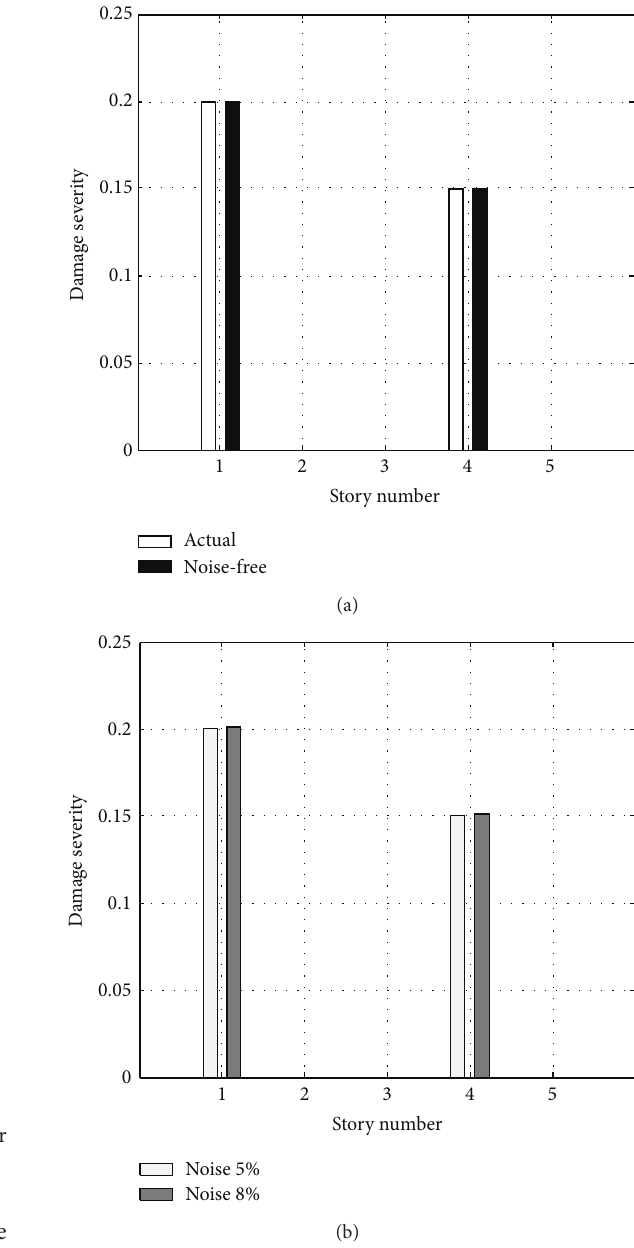
Figure 4: Damage detection results in the five-story shear frame for scenario